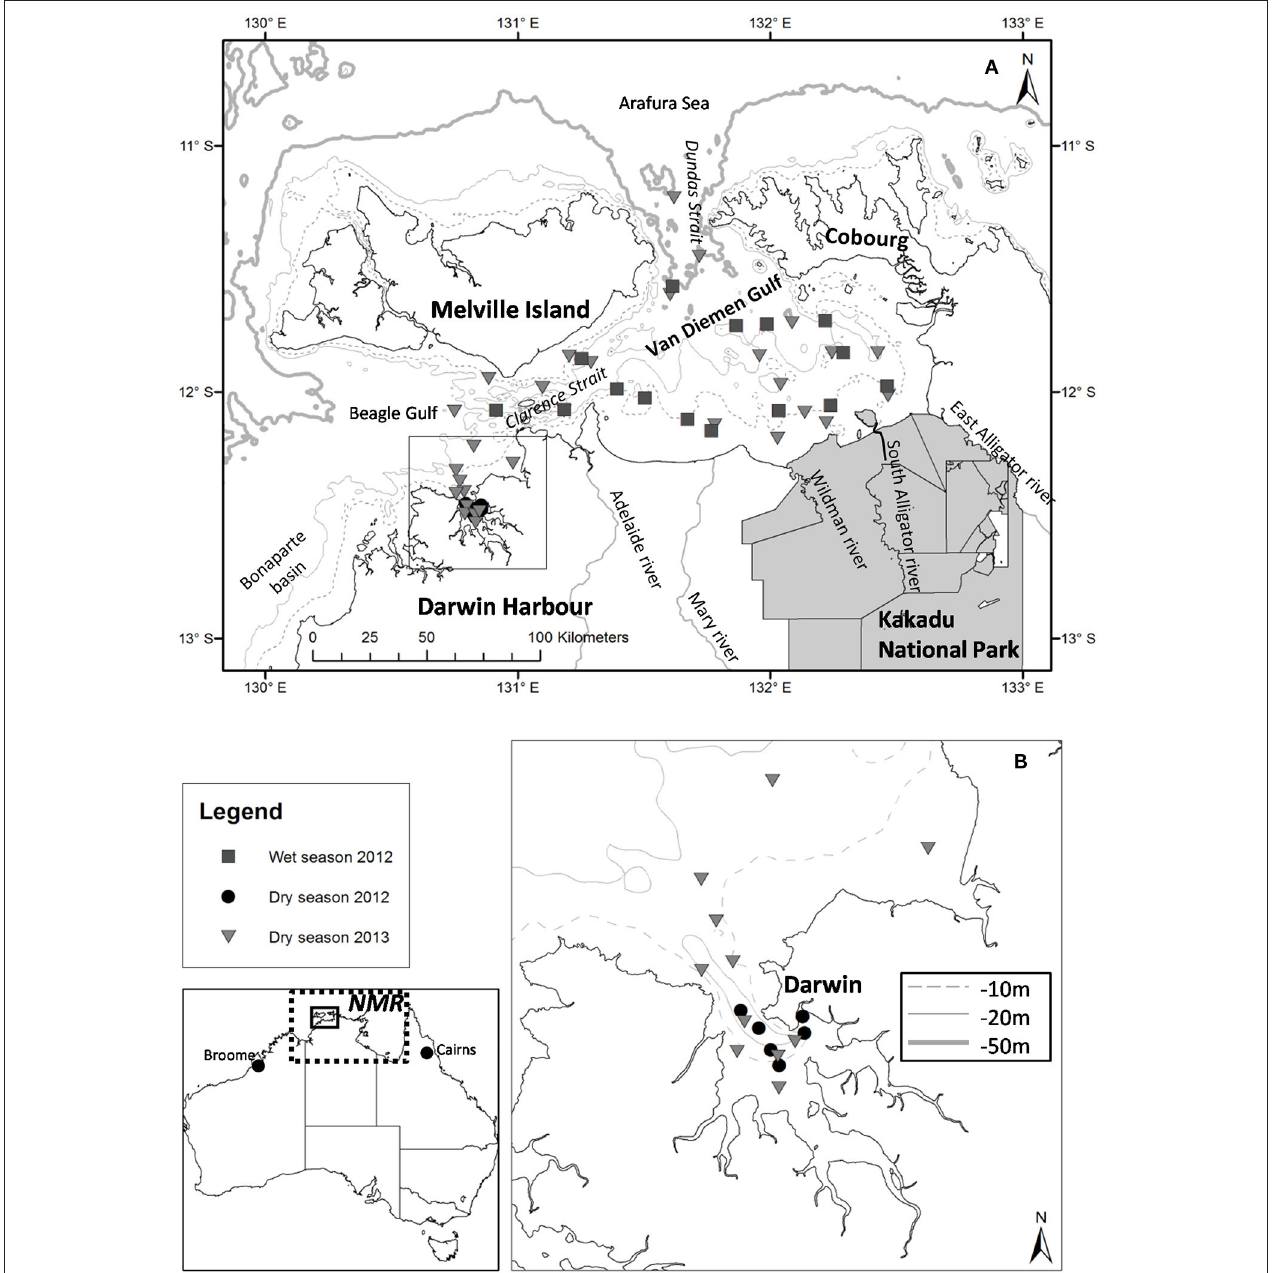
FIGURE 1 | (A) Locations of the dry and wet season sampling stations for the 2012 and 2013 field campaigns; (B) Darwin Harbour (inset). The extent of the Northern Marine Region (NMR; dotted line) is shown. Bathymetry contours are indicated in light gray [isobaths − 10 and − 50m for (A) , and isobaths − 10, − 20, − 50m for (B) ].